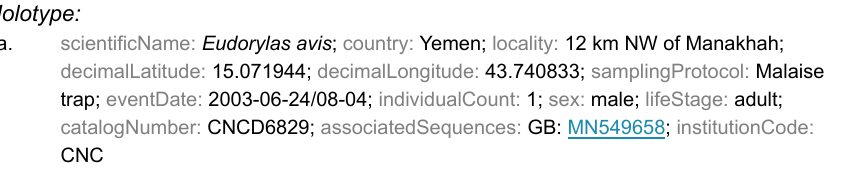
Our single DNA barcode of Eudorylas auctus from Germany (JSS15405) overlaps with barcodes of E. obscurus from France (CNC464954) and E. longifrons from Iran (GB: L T671752). The genitalia of these species are different, so this is likely just a case of incomplete lineage sorting due to ancestral hybridisation or the fact that these are young species whose barcodes have not yet diverged, as seen in many other taxa (e.g. Skevington 2005, Skevington et al. 2007, Young et al. 2016). It does raise the possibility that these three taxa are part of a single variable species with polymorphic genitalia. Future work should explore population genetics within this cluster of species, perhaps using the rapidly evolving marker, ITS2.